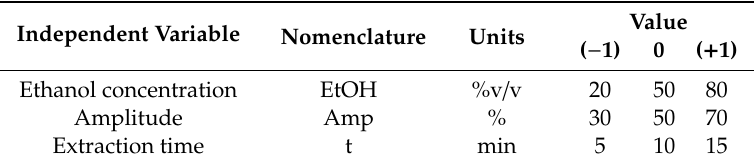
Table 1. Uncoded and coded values of the